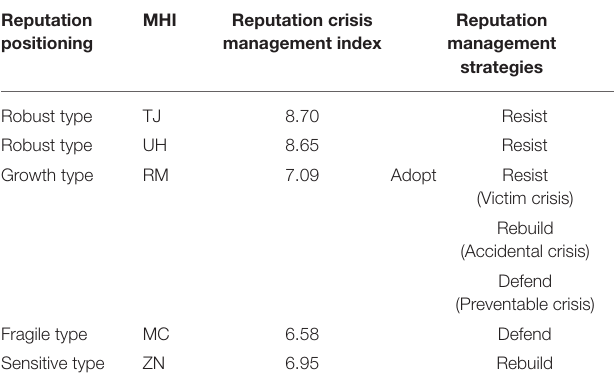
TABLE 5 | Five MHI reputation positioning and management